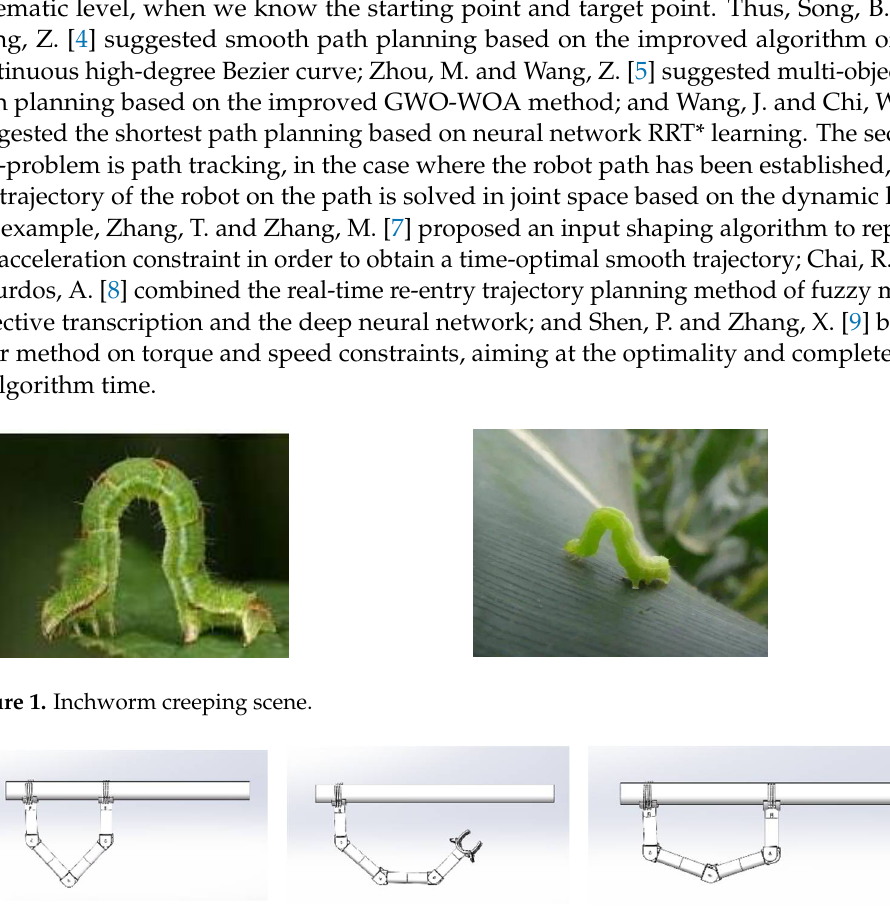
Figure 2. Sketch of the robot crawling.